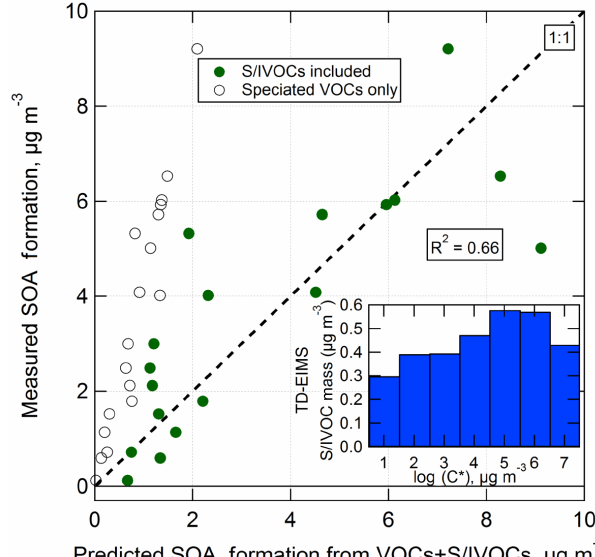
Figure 12. Measured vs. predicted SOA formation from OH oxida- tion of ambient air in an OFR using the OFR185 method. Only the range of photochemical ages with the highest SOA formation (0.4– 1.5 eq. days) was used, and the LVOC fate correction was applied. Predicted SOA formation is estimated using VOCs (described in Sect. 3.6.1) including and without including an empirical 58% SOA yield from S/IVOCs measured by the TD-EIMS (a lower limit of to- tal S/IVOCs). Inset: average S/IVOC concentrations as a function of the log of the saturation vapor concentration C ∗ . This comparison includes all data for which S/IVOCs and SOA formation in the OFR were concurrently measured (26, 28–29 July; 9–10, 12–13 August). For some data points, PTR-TOF-MS data were not available, so the VOC contribution was estimated using the linear fit in Fig.